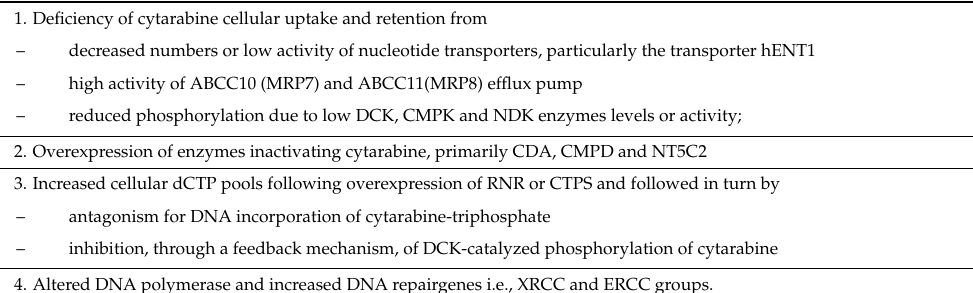
Table 4. Mechanisms of resistance within the cytarabine